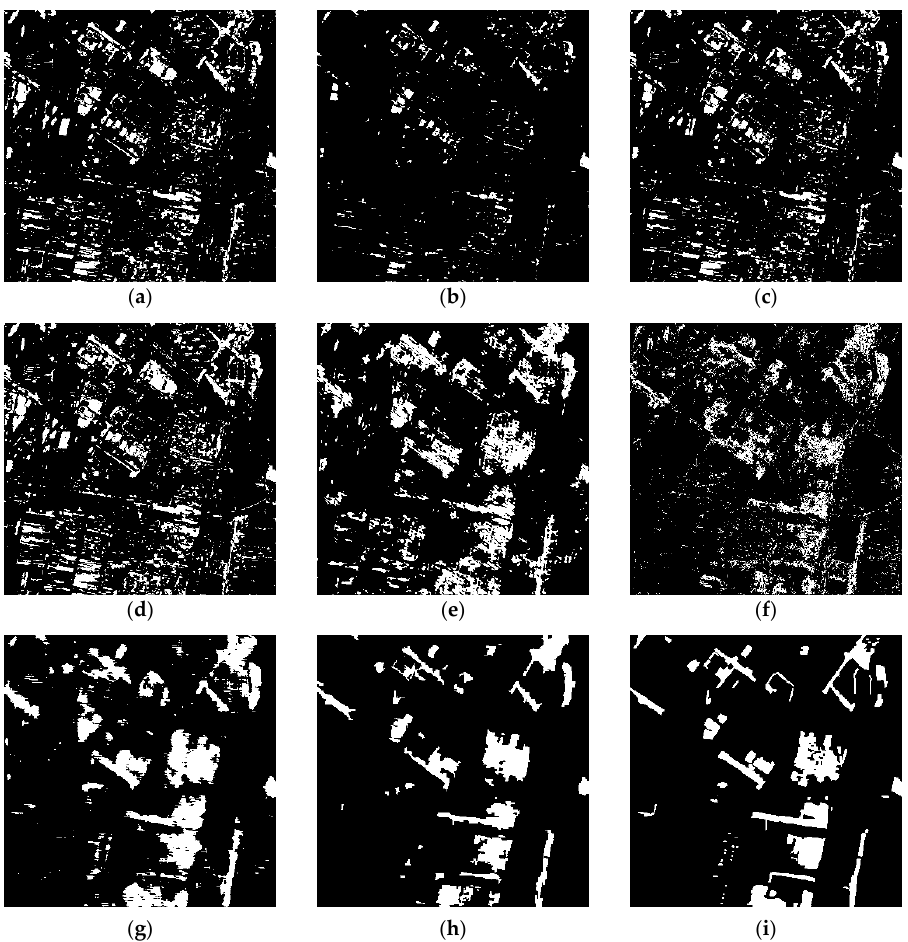
Figure 9. Change detection maps obtained on the second location by: ( a ) Extreme Learning Machine (ELM), ( b ) Support Vector Machine (SVM), ( c ) Multiple Linear Regression (MLR), ( d ) Artificial Neural Network (ANN), ( e ) Deep Convolutional Neural Network (DCNN) ( ω = 13), ( f ) Traditional Siamese Convolutional Neural Network (TSCNN) ( ω = 13), ( g ) Deep Siamese Multi-scale Convolutional Network (DSMS-CN) ( ω = 13), ( h ) Deep Siamese Convolutional Network Based on Convolutional Feature Extraction Module (OB-DSCNH) ( ω = 13, l = 30), ( i ) Reference